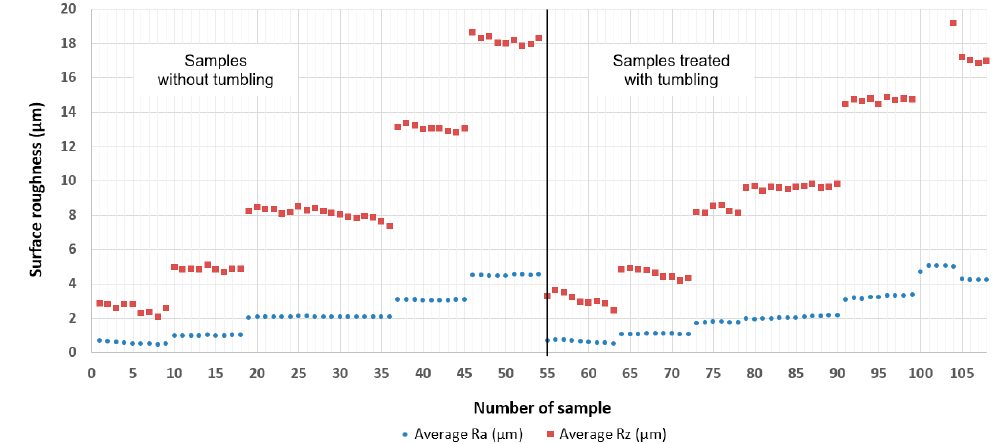
Figure 8. The surface roughness of tested samples.